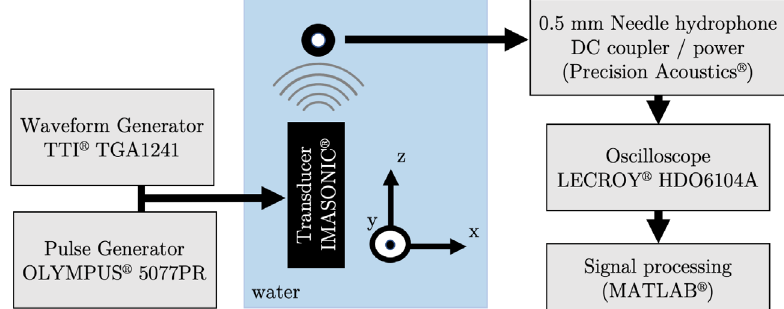
Figure 2. General synoptic